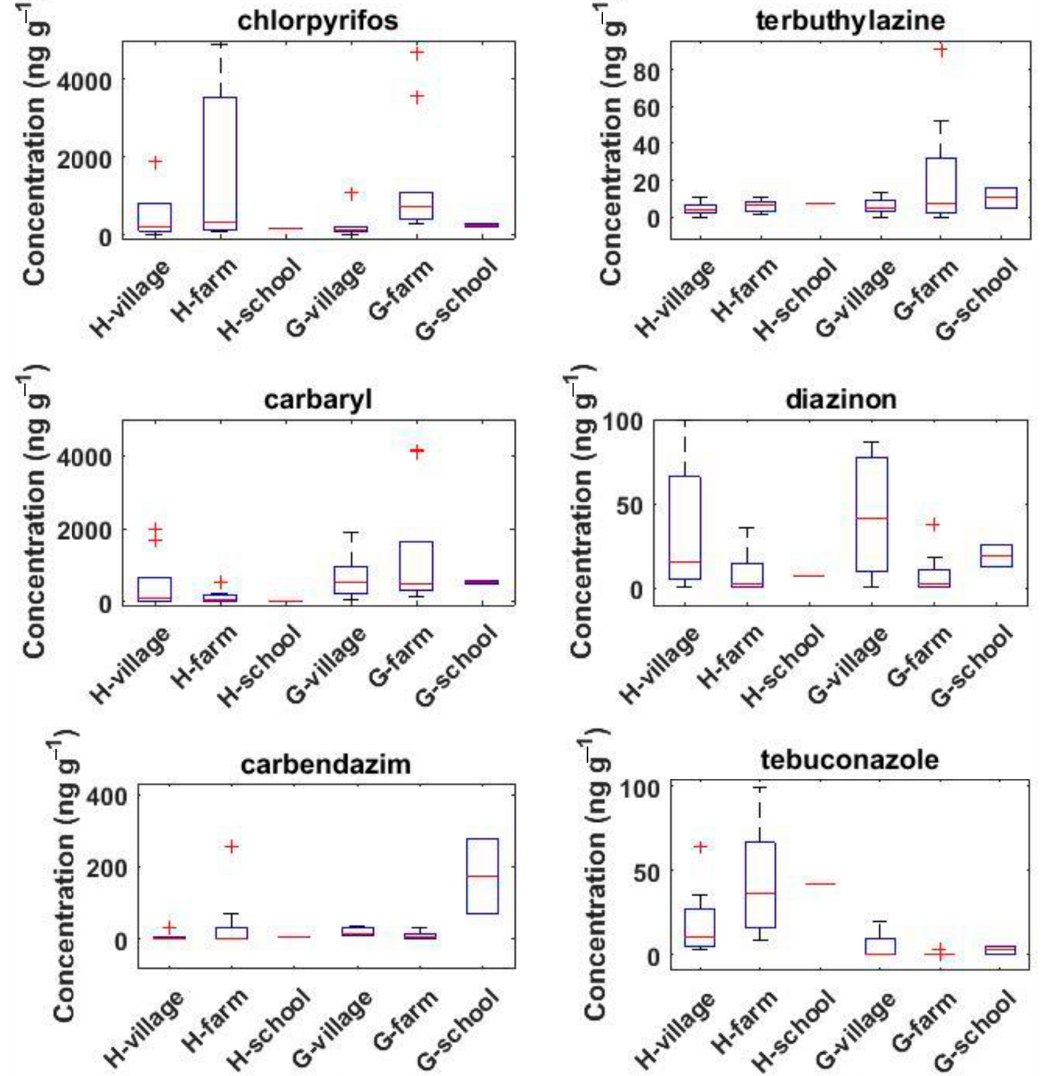
Figure 4. Spatial variations in dust levels of pesticides (in ng g − 1 ) among the different sites and areas from the samples collected on day 7 only ( n = 41). H and G denote Hex River Valley and Grabouw, respectively. Some outliers are not shown for better visibility. Boxplots represent the 25–75th percentile, whiskers represent the minimum and maximum values (excluding outliers which are shown as the red crosses) and the line within the box represents the median